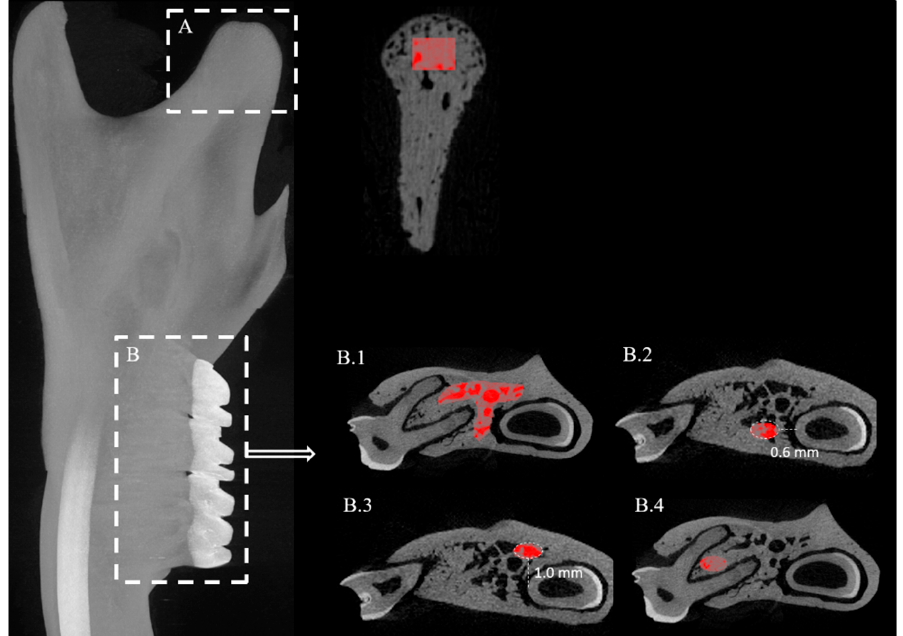
Figure 4. Micro ‐ CT image of the rat mandible showing the regions of interest (ROI). ( A ) Condyle (rectangular ‐ shaped ROI); ( B.1 ) Manually drawn ROI encompassing the trabecular bone surrounding the molar; ( B.2 ) Ellipsoid ‐ shaped ROI positioned in the lingual region from the roots of the molar; ( B.3 ) Ellipsoid ‐ shaped ROI positioned in the buccal region from the molar; and ( B.4 ) Trabecular bone in ellipsoid ‐ shaped ROI at the inter ‐ radicular septum.